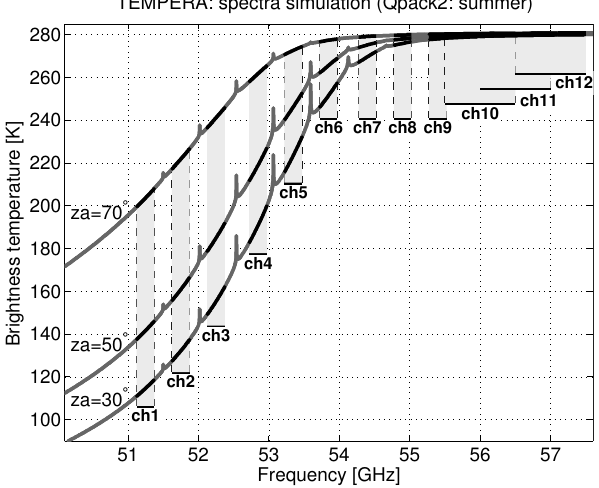
Figure 2. Simulated brightness temperatures using ARTS model for the TEMPERA radiometer at different zenith angles (30, 50 and 70 ◦ ). The grey bars indicate the 12 channels of the filter bank. Table 1. Frequencies ( f ) and bandwidths ( B ) of TEMPERA’s tro- pospheric channels